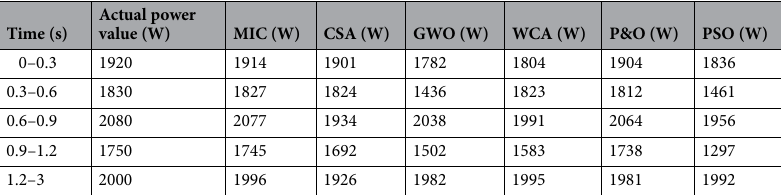
Table 5. The output power values of solar array in various temperature conditions.